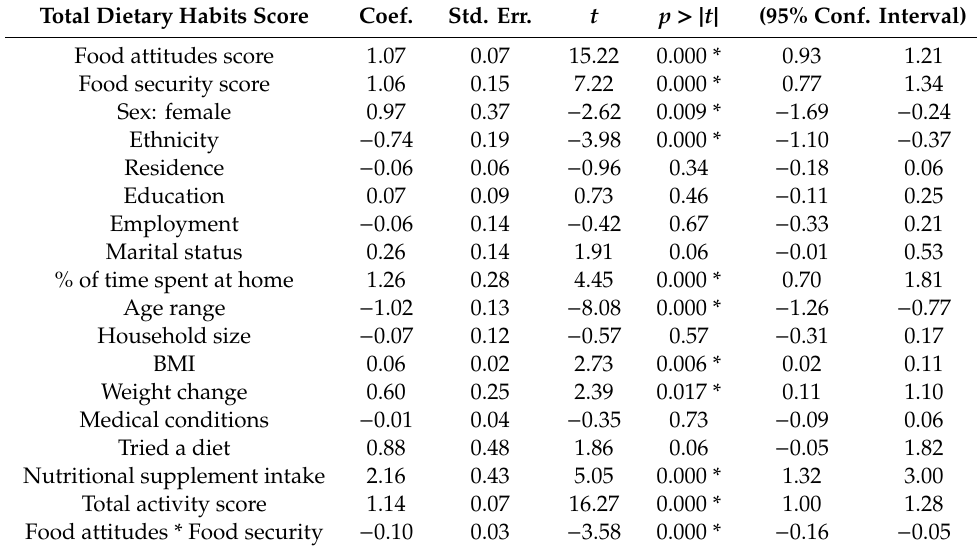
Table 4. Multivariable associations and total dietary habits score. Total Dietary Habits Score Coef. Food attitudes